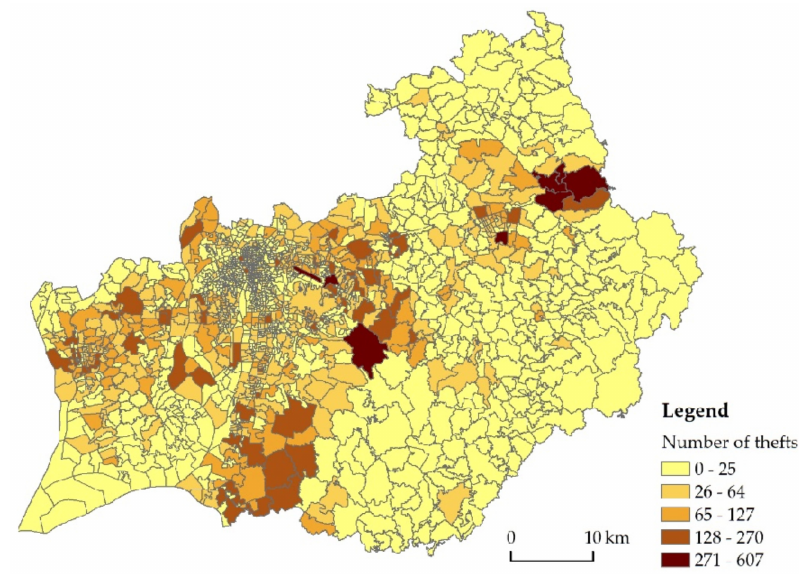
Figure 1. The spatial distribution of the number of thefts.